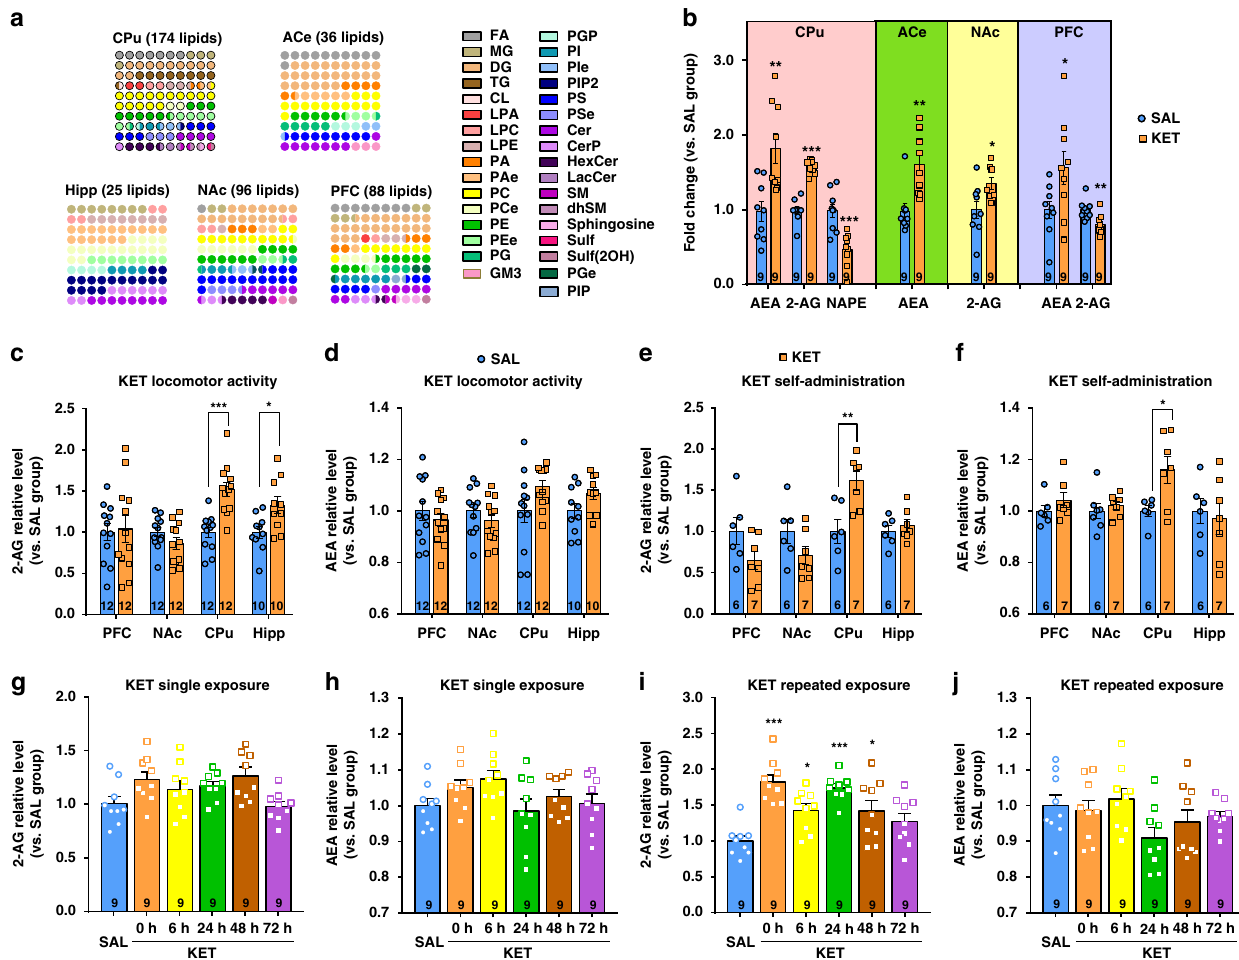
Fig. 1 2-AG level in the dorsal striatum is signi fi cantly elevated by ketamine. a Ketamine alters the lipid composition of brain in mice. Dot-plot graphic was adopted to exhibit the altered lipid subclass. The color of the dots represents a lipid subclass and the quantity of the dots represents the percentage. The lipids of CPu showed the most obvious alterations with 174 modi fi ed lipids. b Endocannabinoids changed signi fi cantly in the brain. The lipid level was normalized automatically by QI software and recalculated the relative levels compared to the saline control group (unpaired two-tailed t test, AEA in CPu t (16) = 3.562, P = 0.0026; 2-AG in CPu t (16) = 9.877, P < 0.0001; NAPE in CPu t (16) = 4.413, P = 0.0004; AEA in ACe t (16) = 3.678, P = 0.002; 2-AG in NAc t (16) = 2.558, P = 0.0211; AEA in PFC t (16) = 2.264, P = 0.0378; 2-AG in PFC t (16) = 3.239, ** P = 0.0051). c Ketamine (15 mg/kg) signi fi cantly elevated 2-AG level both in the CPu and hippocampus of mice under hyperlocomotion paradigm (unpaired two-tailed t test, t (22) = 4.805, P < 0.0001; t (18) = 2.666, P = 0.0158). d Ketamine (15 mg/kg) did not change the AEA level in the brain of mice under hyperlocomotion. e Ketamine self- administration (0.5 mg/kg/infusion) signi fi cantly elevated 2-AG level in the CPu (unpaired two-tailed t test, t (11) = 3.378, P = 0.0062). f Ketamine self- administration (0.5 mg/kg/infusion) signi fi cantly increased AEA level in the CPu (unpaired two-tailed t test, t (11) = 2.626, P = 0.0236). g , h The levels of 2-AG and AEA were not altered after single ketamine exposure (15 mg/kg). i 2-AG level was signi fi cantly increased after repeated ketamine exposure (15 mg/kg; one-way ANOVA, followed by Dunnett ’ s multiple comparisons test, F (5,48) = 9.109, P < 0.0001; 0 h vs. SAL, P < 0.0001; 6 h vs. SAL, * P = 0.0187; 24 h vs. SAL, P < 0.0001; 48 h vs. SAL, P = 0.0207). j AEA level was not altered after repeated ketamine exposure (15 mg/kg). Data are shown as mean ± SEM. Compared to SAL group, * P < 0.05, ** P < 0.01, *** P < 0.001. SAL saline, KET ketamine, ACe central amygdaloid nucleus, CPu caudate nucleus and